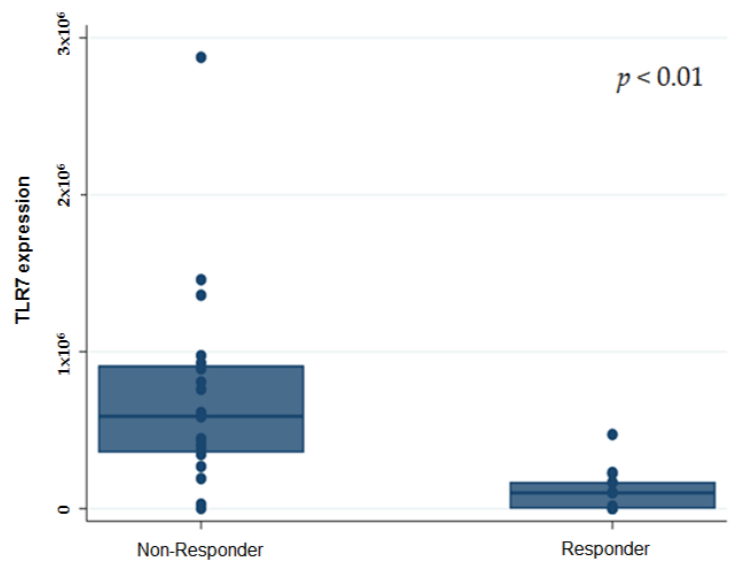
Figure 2. Box plot for TLR7 gene expression according to ICI-Responders and ICI-Non-Responders.